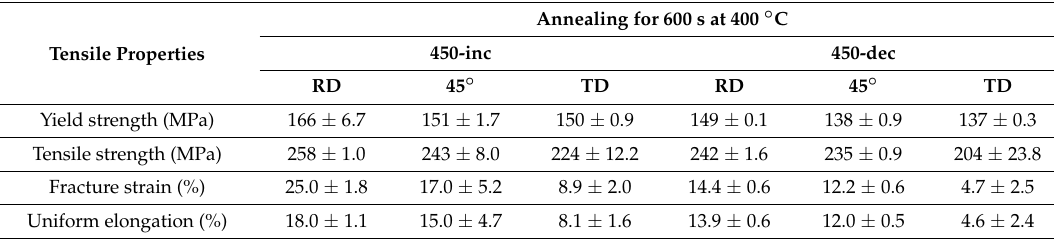
Figure 6. Stress strain curves of the annealed sheets for 600 s at 400 °C after rolling by ( a ) 450-inc and ( b ) 450-dec schemes. Table 2. Mechanical properties of the annealed sheets from tensile